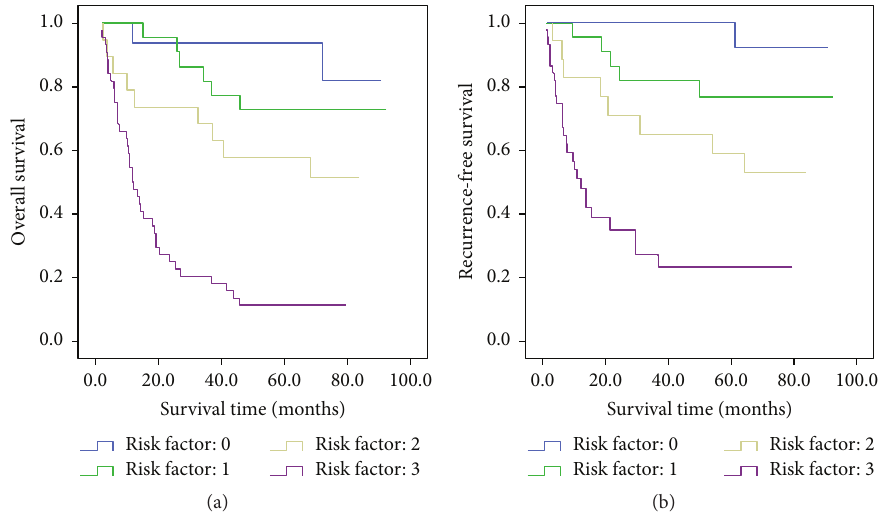
Figure 3: Prognostic impact of biomarker risk score system. (a) Overall survival. (b) Recurrence-free